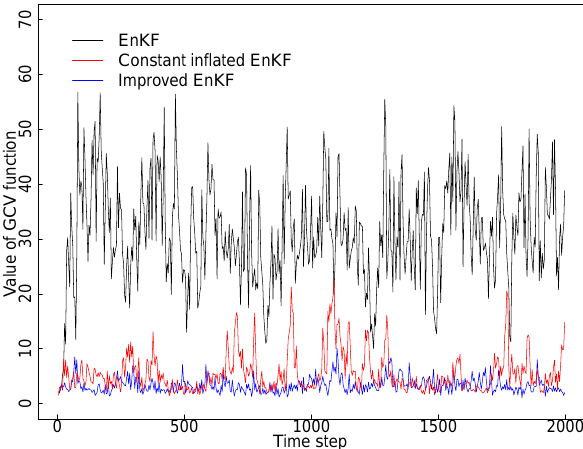
Figure 6. GCV function values of the conventional EnKF (black line), the constant inflated EnKF (red line) and the improved EnKF (blue line) for the Lorenz-96 experiment with 40-observation and 30-ensemble member. The constant multiplicative inflation factor is set as 1.88.